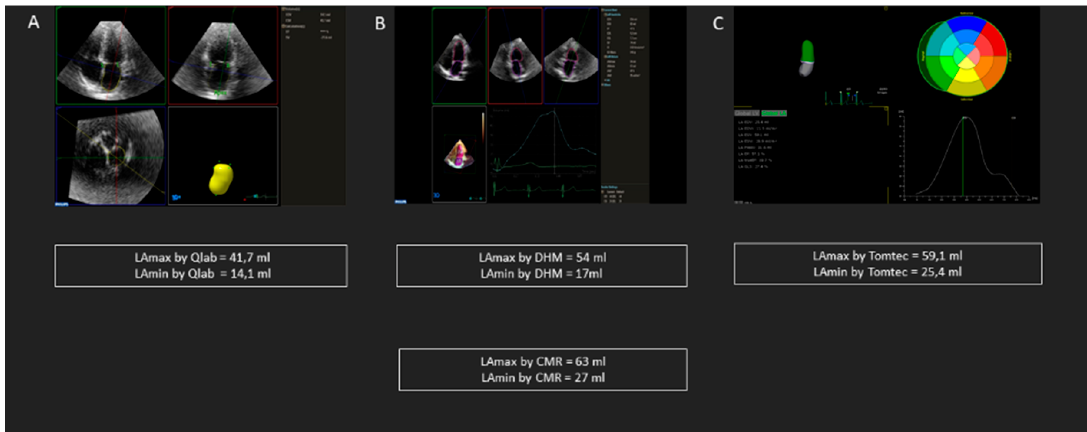
Figure 2. Example of left atrium measurements in the same patient using different three-dimensional methods: ( A ) 3DE Qlab, ( B ) Dynamic HeartModel, ( C ) Tomtec.